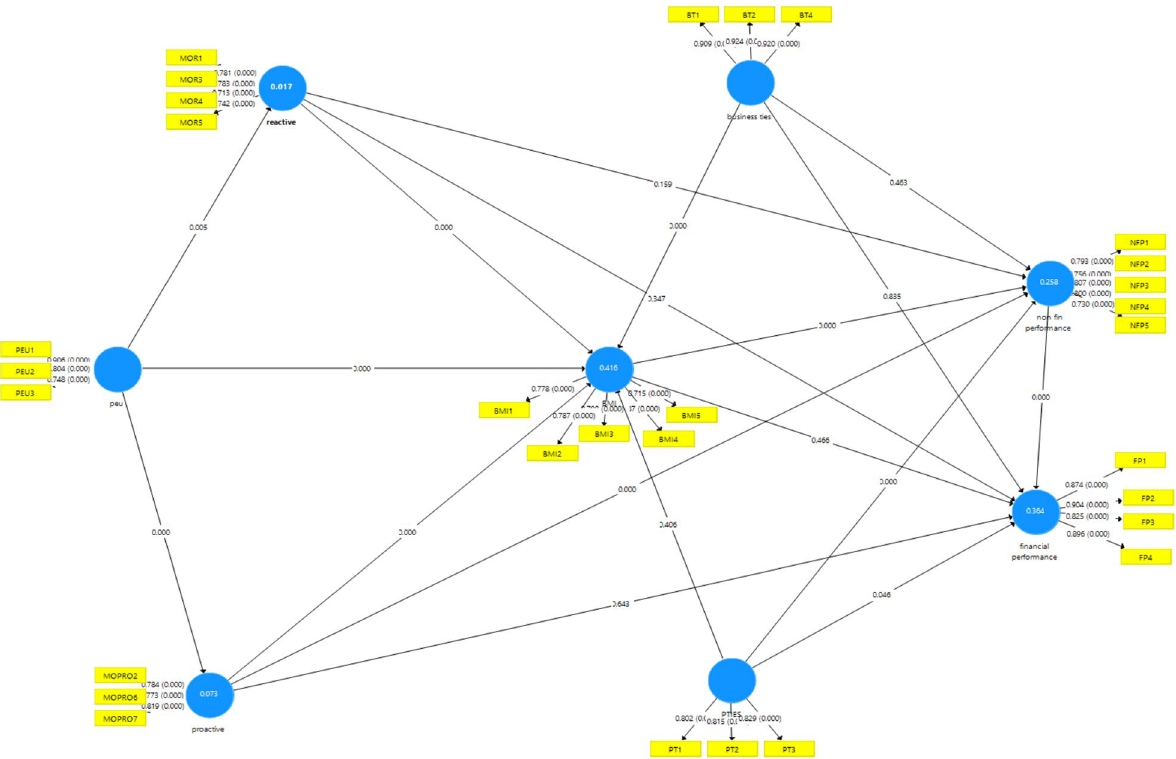
Fig. 2 Model tested . Source : Smart PLS 3.3